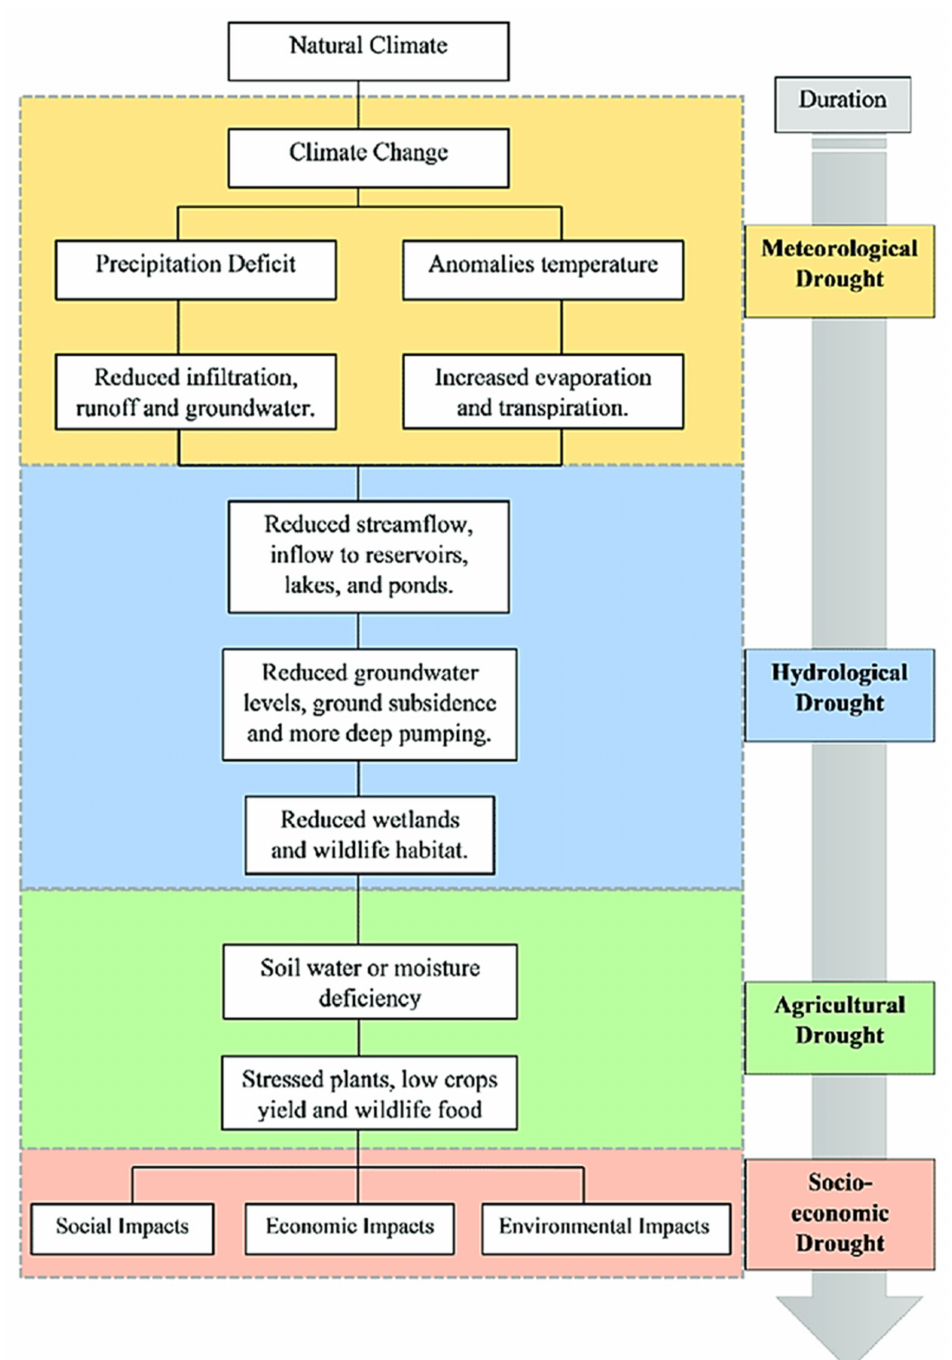
Figure 2. General diagram of different types of